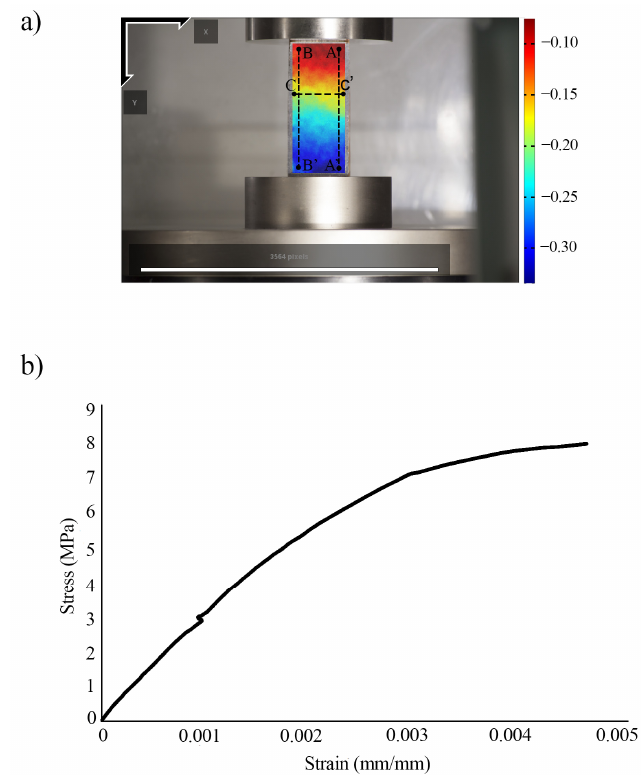
Figure 3. Results after the experimental campaign (2D DIC). ( a ) Deformation measurement, expressed in pixels, between two captures and positioning of the virtual extensometers; ( b ) Stress-strain curve obtained with the virtual extensometer A-A’.